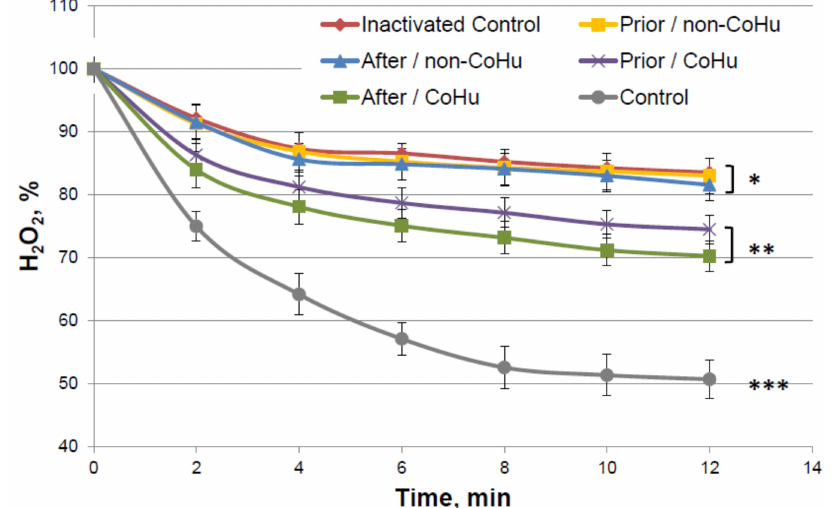
Figure 4. Residual quantity of H 2 O 2 (catalase substrate) in the catalase-assisted degradation reac- tion. Data reflect the activity of the enzyme. *, ** and ***—Lines with different superscripts differ